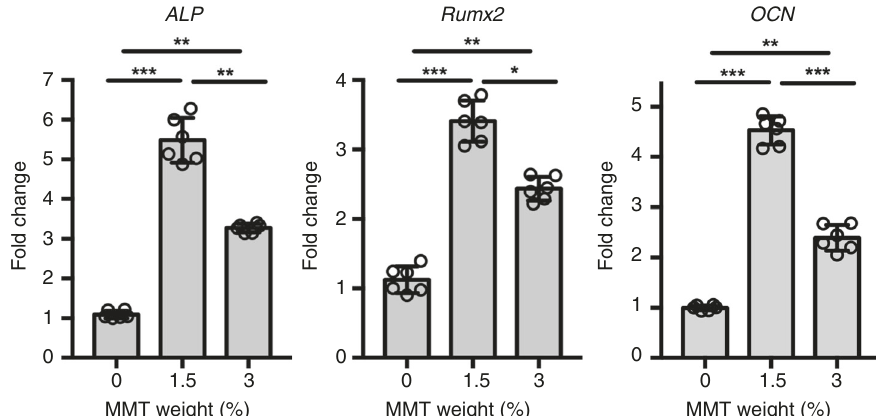
Fig. 6 Gene markers evaluation of osteogenesis. The bioactivity of encapsulated cells was evaluated with qRT-PCR in photocross-linked MeGC-MMT nanocomposite hydrogels with various amount of MMT (0%, 1.5%, 3%). The hydrogels were cultured in the osteogenic medium for various time. ALP and Runx2 were examined at day 7, and OCN was measured at day 14. Error bars indicate standard deviation (three independent cultures, n = 6), * p < 0.05, ** p < 0.01, and *** p < 0.001 (ANOVA followed by Tukey ’ s post hoc test)